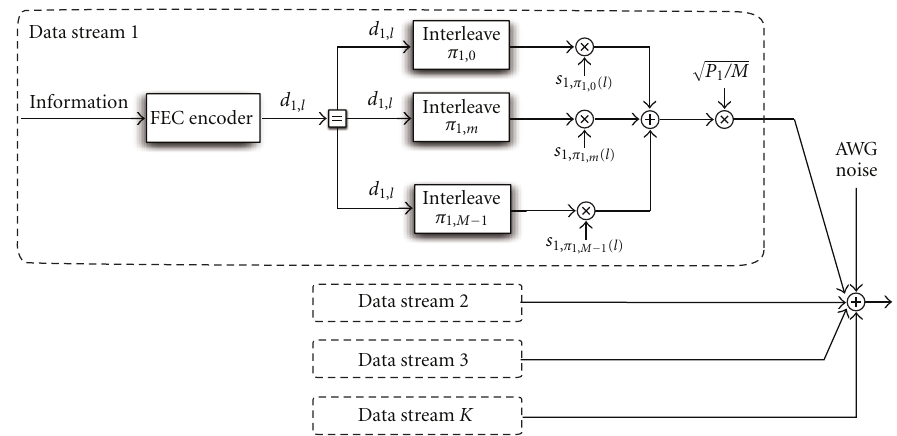
Figure 2: Modulator with superimposed binary data